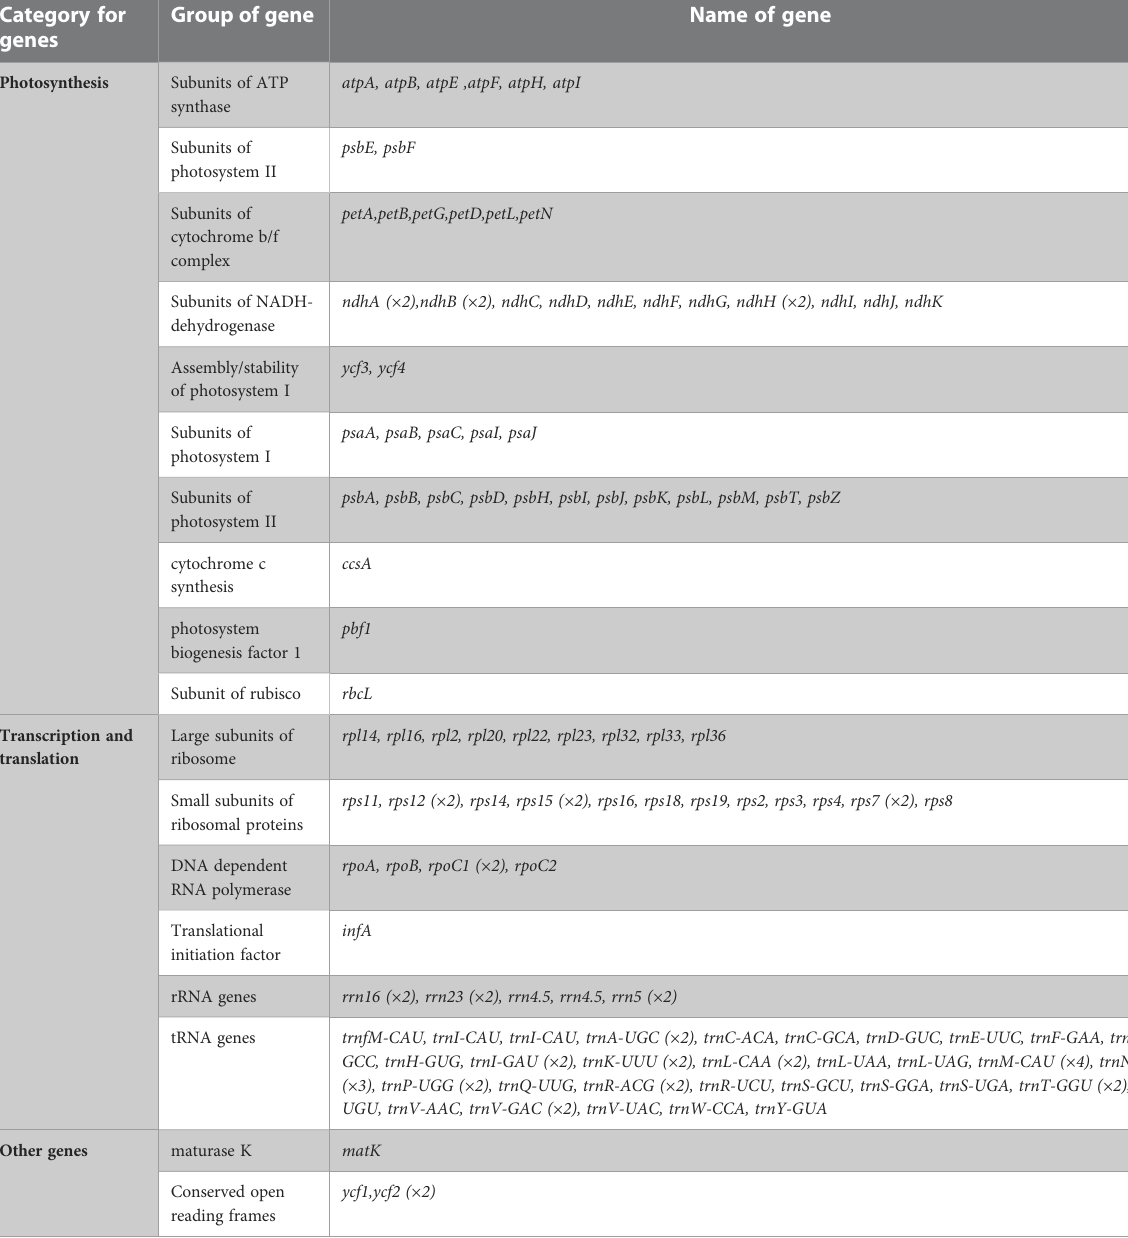
TABLE 1 The annotated genes in the chloroplast genome of I. pes-caprae. Category